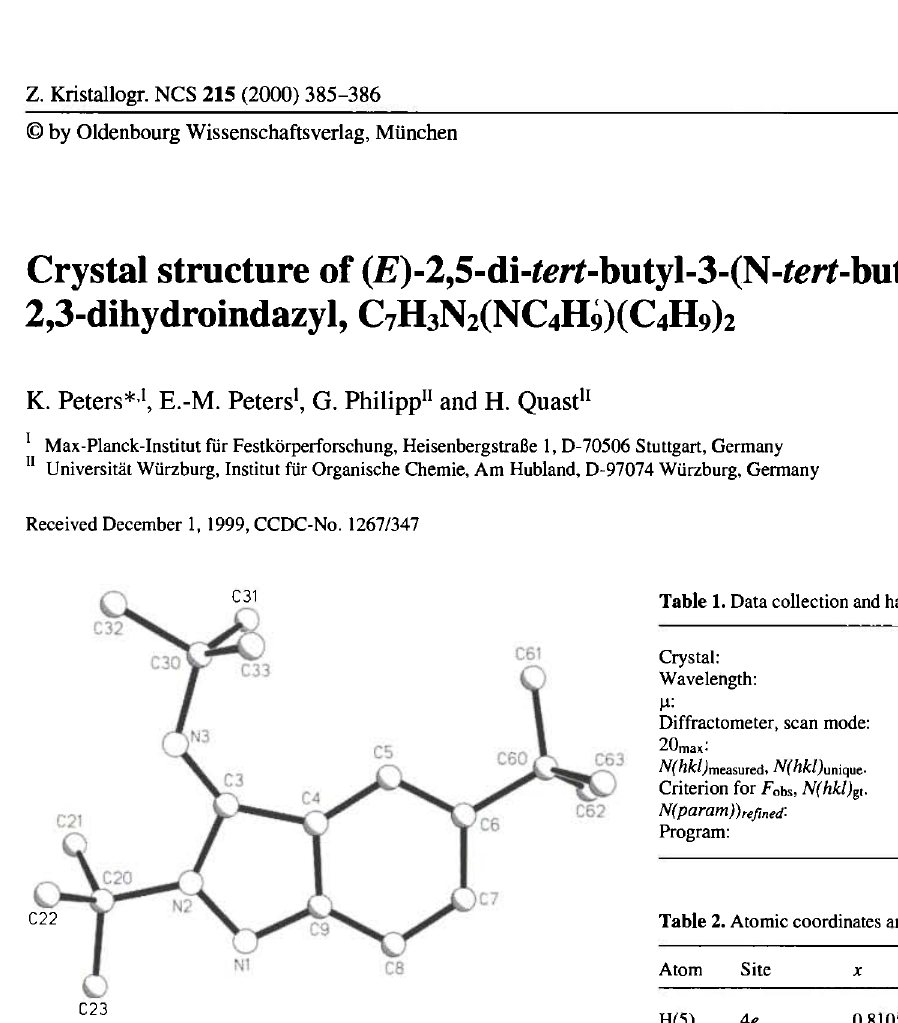
Table 2. Atomic coordinates and displacement parameters (in Ä 2